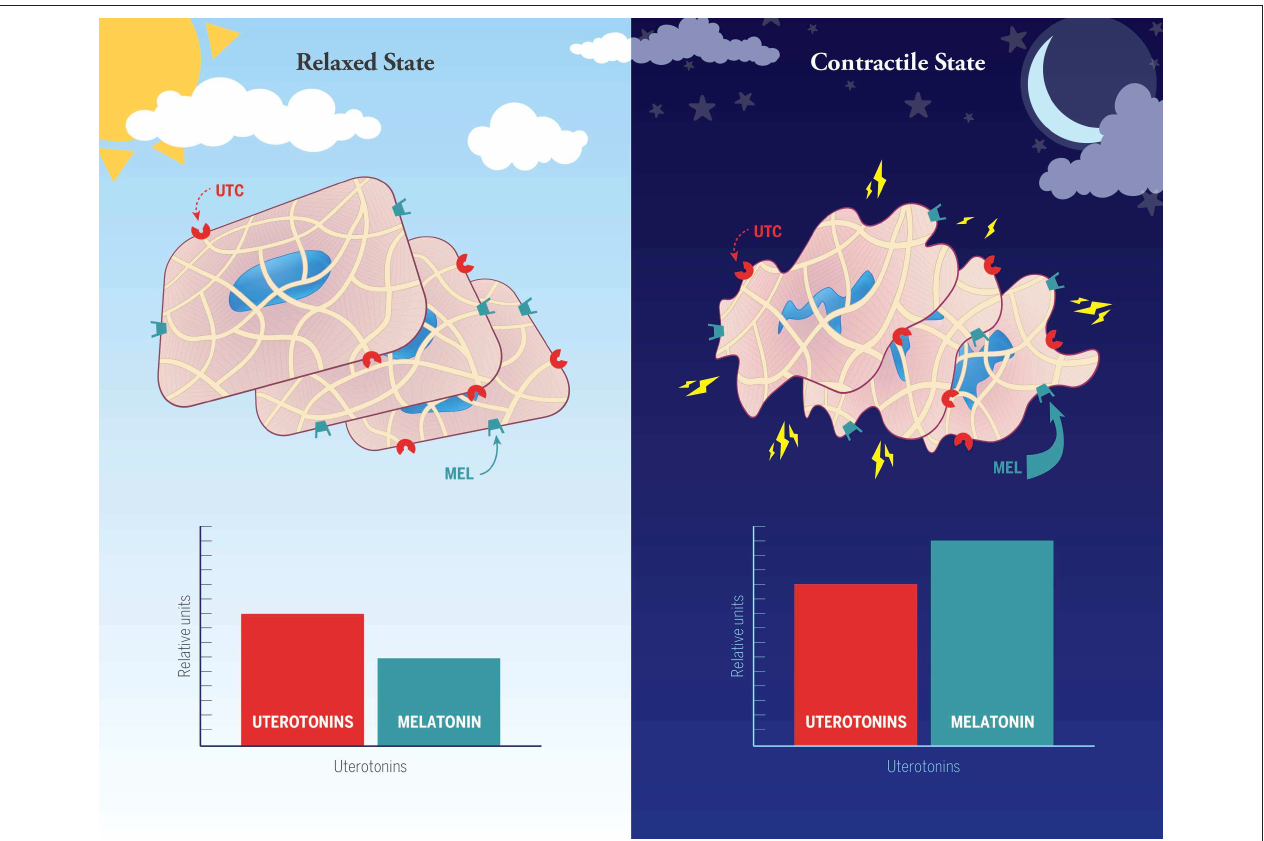
FIGURE 1 | Hypothesized involvement of melatonin with other non-specified uterotonins (e.g., oxytocin, prostaglandins, cytokines) in the establishment of the well-known day night difference in human myometrial contractions during normal late term pregnancy and labor. In this working model the uterine smooth muscle cells are suggested to be in a relaxed state during the daytime because of low levels of melatonin and other unspecified uterotonins (note: the histograms are not meant to be quantitative, but rather to depict relative differences between day and night). High nocturnal uterine contractility is proposed to arise as a synergistic response between uterotonic factors and melatonin, the latter of which is markedly elevated at night. Suppression of nocturnal melatonin levels in late term pregnant women has been demonstrated to significantly reduce uterine contractility (